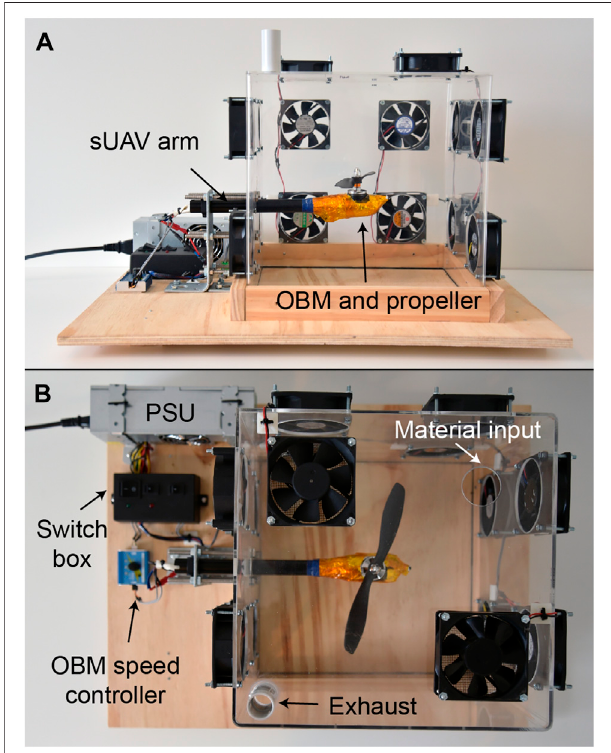
FIGURE 1 | Experimental setup used to investigate the interaction between a sUAV motor-propeller assemblage and volcanic ash. (A) Frontal viewshowingthesUAVarmpositionedatthecenteroftheplexiglasscube. (B) Top view showing the control section (switch box and OBM